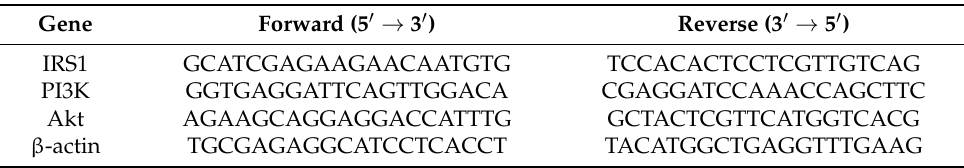
Table 1. Primer for